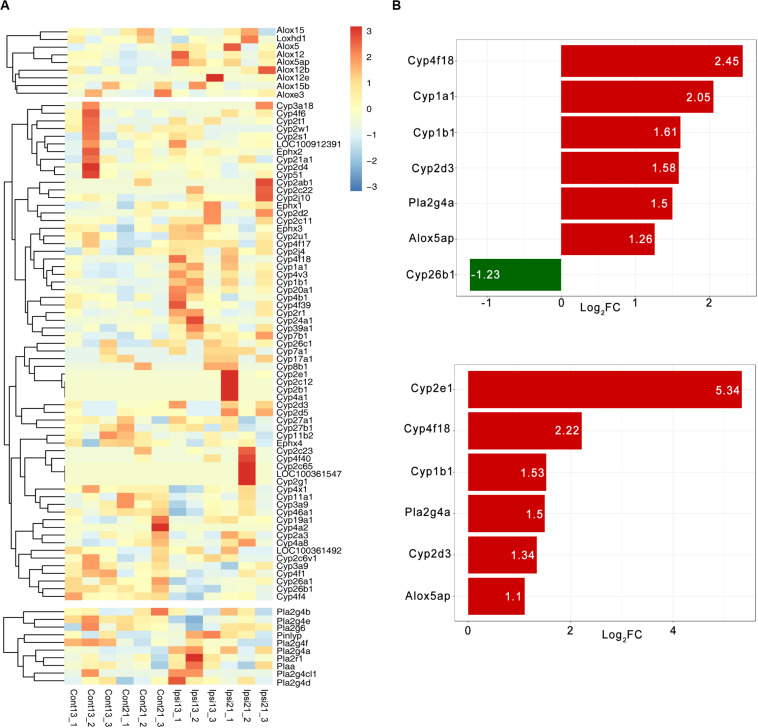
The expression pattern of oxylipins relative enzymes in ICH. (A) The hierarchical cluster of the heat map shows the expression of oxylipins related enzymes in ICH (n = 3); (B) Differential expression of oxylipins related enzymes in 13-month-old ICH rats (top panel) and 22-month-old ICH rats (bottom panel) (vs contralateral hemisphere, p < 0.01 and Log2FC > 1, n = 3).